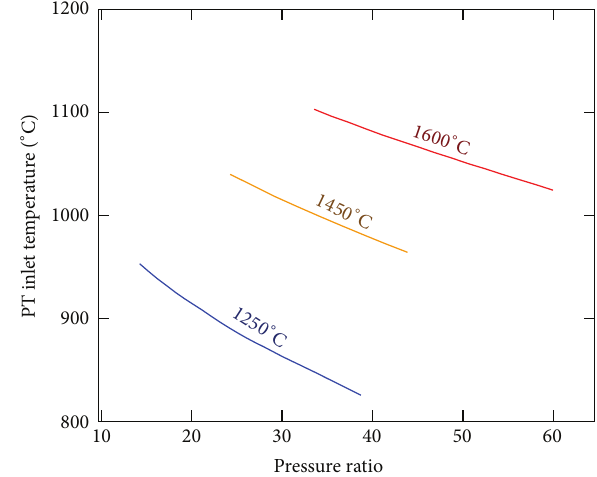
Figure 10: Gross efficiency as function of pressure ratio and turbine entry temperature for the Graz cycle.